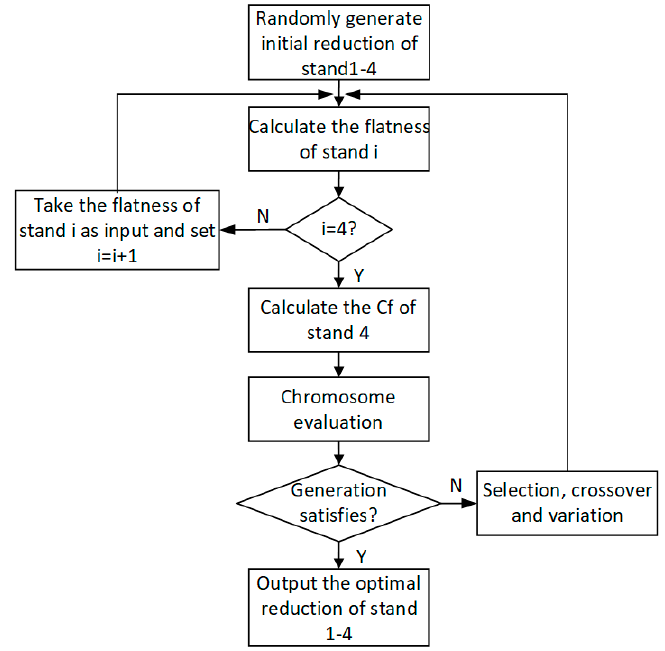
Figure 12. The optimization flow chart.